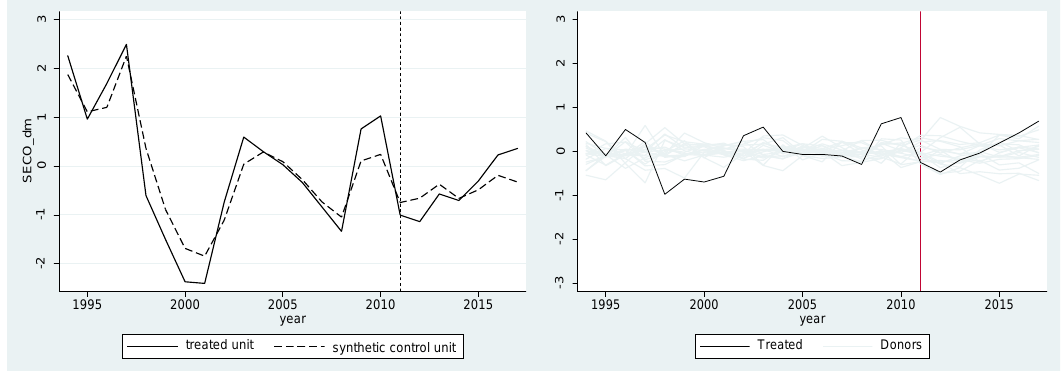
Figure 7. Outcome for Jura: Demeaned SC and unemployment rate, including all pre-treatment variables as predictors.